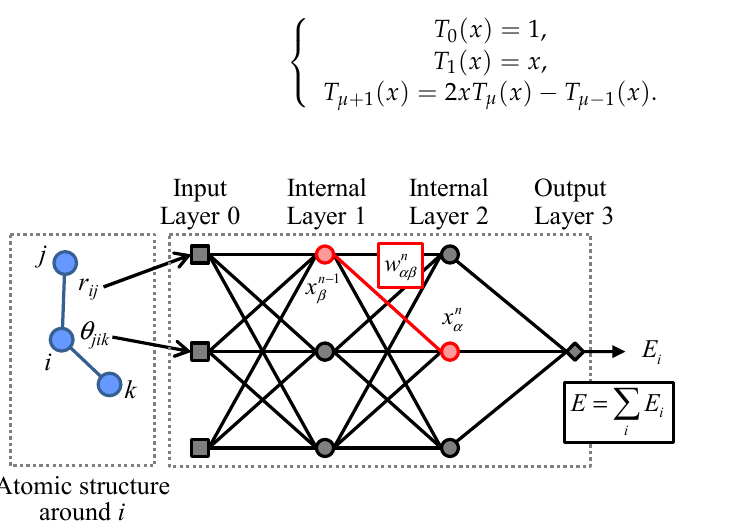
Figure 1. Schematic illustration of ANN potential model. This figure shows an exemplified network model with two internal layers (layers 1 and 2) and three nodes each in the input and internal layers.